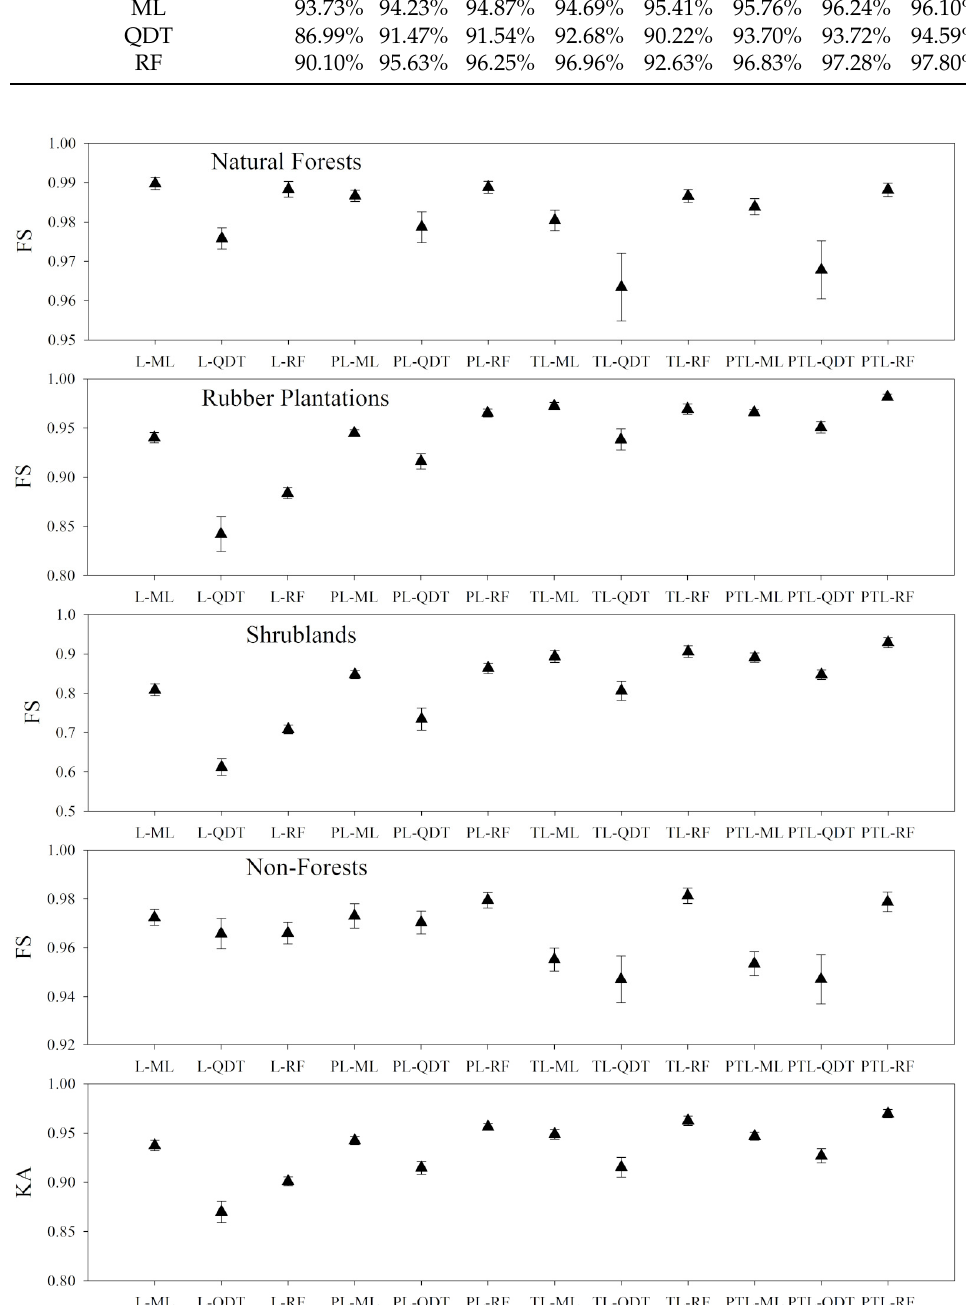
Figure 5. The accuracy assessment with F1 Score (FS) and kappa coefficient (KA) of the three classifiers (ML, QDT, and RF) with different data input (L, PL, TL, and TPL, see Table 2 for the full name of each data input).